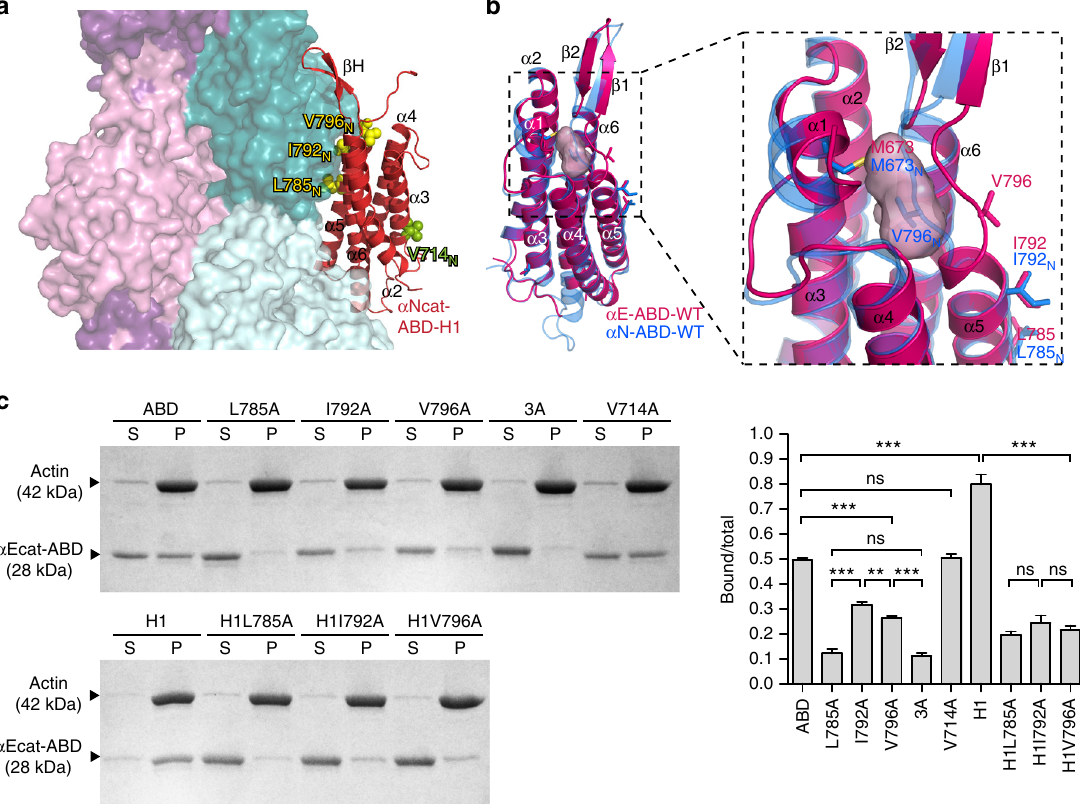
Fig. 5 Identi fi cation of the critical actin-binding site residues in α -catenin. a Model of the α cat-ABD (red) bound to two axially adjacent actin monomers (dark and light teal) within F-actin, based on the vin-ABD/F-actin cryo-EM structure (PDB ID: 3JBI). b Comparison of high-resolution crystal structures of α Ecat-ABD-WT (red) and α Ncat-ABD-WT (blue). The overall structure of α Ecat-ABD-WT closely resembles α Ncat-ABD-WT, as two ABD structures can be superposed with RMSD of 0.53 Å over 156 residues. A close-up view (right) shows that α Ecat-ABD-WT contains a cavity (pink molecular envelope), which could accommodate V796 in a cryptic state similar to V796 N in the α Ncat-ABD-WT structure. c Actin cosedimentation assays of α Ecat-ABD variants: WT, L785A, I792A, V796A, 3A, V714A, H1, H1L785A, H1I792A, and H1V796A. Data are presented as mean ± SEM ( N = 3). Signi fi cance by ANOVA: ** P < 0.01, *** P <